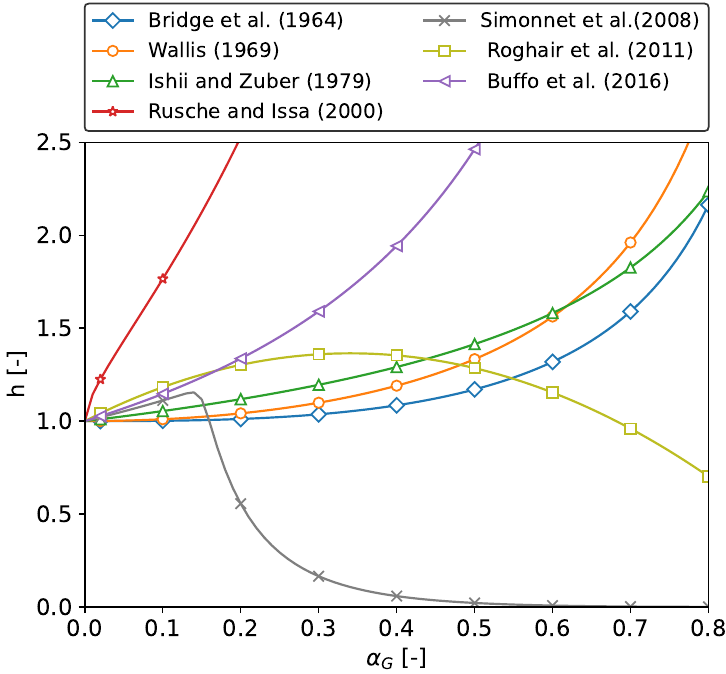
Figure 7. Comparison of published Swarm factor as a function of local void fraction for bubbles with d b of 6.5 mm. Comparison between the correlations of Bridge et al. (1964) [22], Wallis (1969) [23], Ishii and Zuber (1979) [17], Rusche and Issa (2000) [24], Simonnet et al. (2008) [27], Roghair et al. (2011) [25] and Buffo et al. (2016) [26]. Note the discrepancy between the correlation proposed by Simonnet et al. (2008) [27] and the